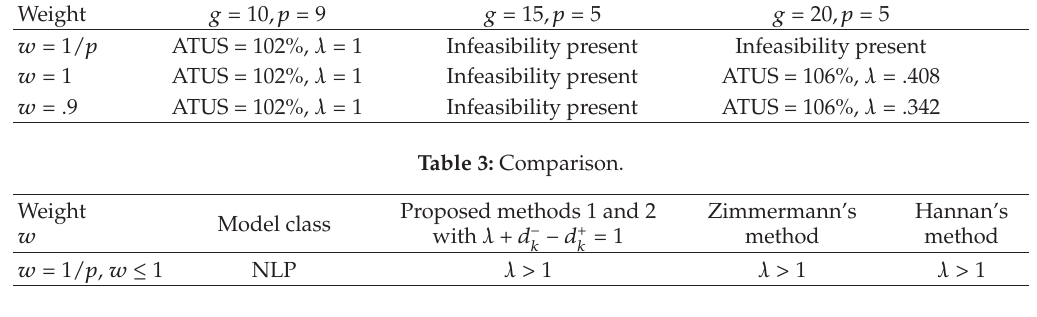
Table 4: Solution of the fuzzy fractional goal programming problem. Tiwari’s weighted additive